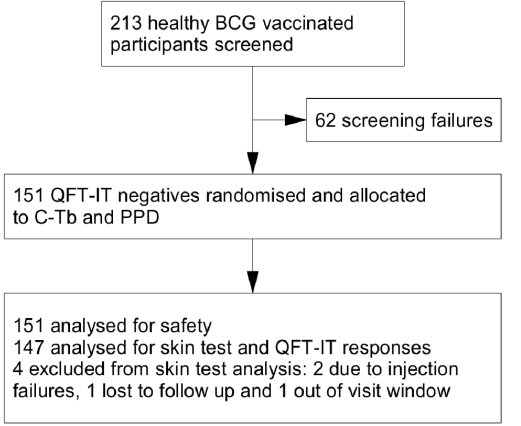
Figure 2. Flow diagram of specificity trial. BCG vaccinated, healthy, QFT-IT negative participants received 0.1 m g C-Tb and 2 TU PPD RT 23 SSI in either arm.